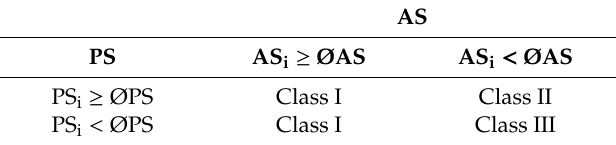
Table 5. Classification and assigned numerical values.